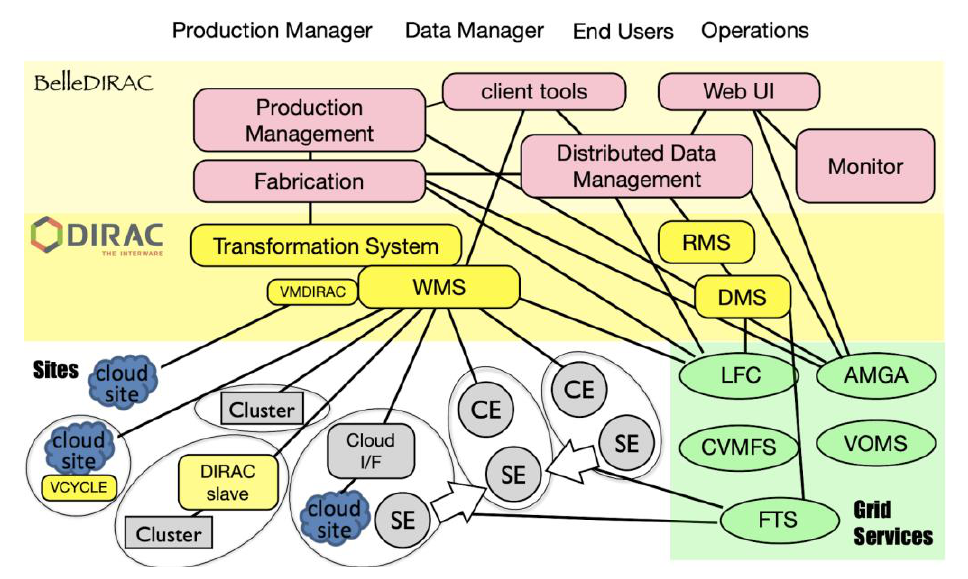
Fig. 1. The Belle II distributed computing